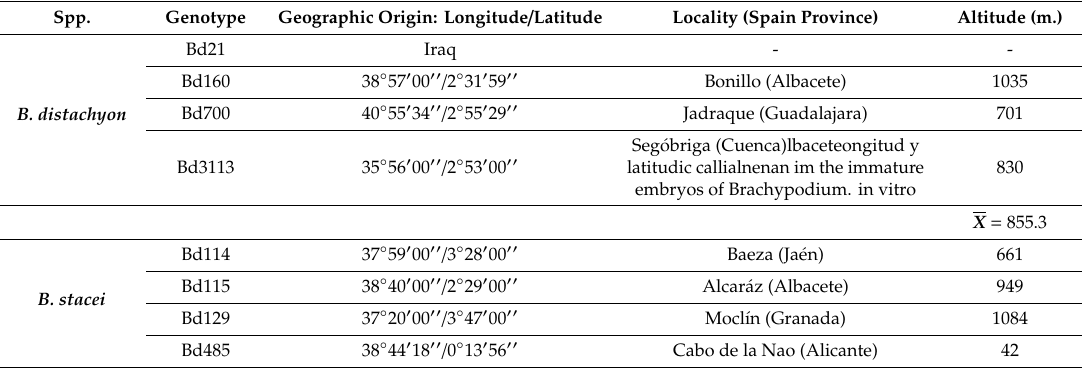
Table 1. Species and genotypes of B. distachyon , B. stacei, and B. hybridum used in this study and their geographic